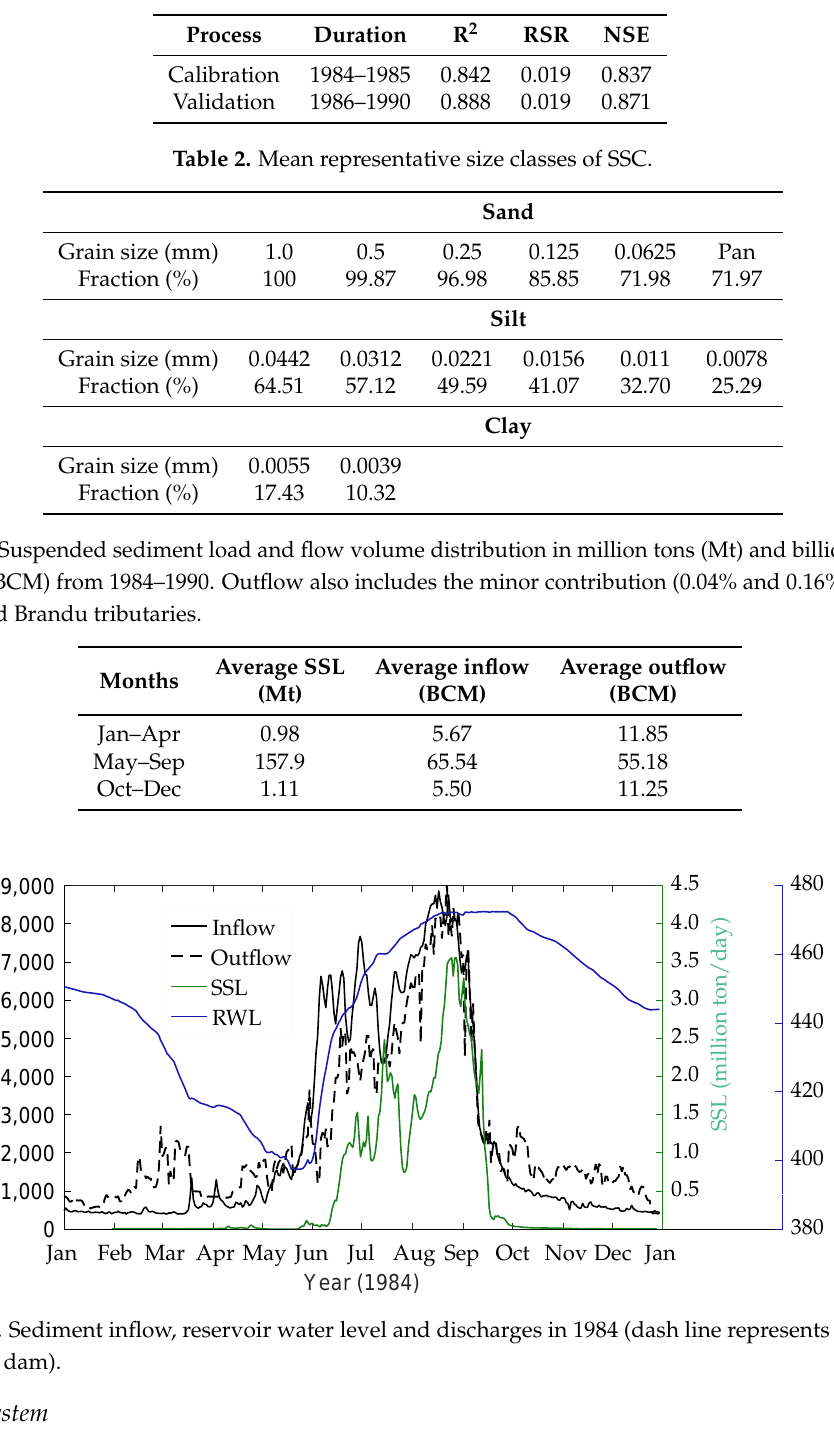
Table 1. Statistical performance of WA-ANN for reconstructing SSL in study period (only high flows from May to September). Sediment load was calculated in [11].